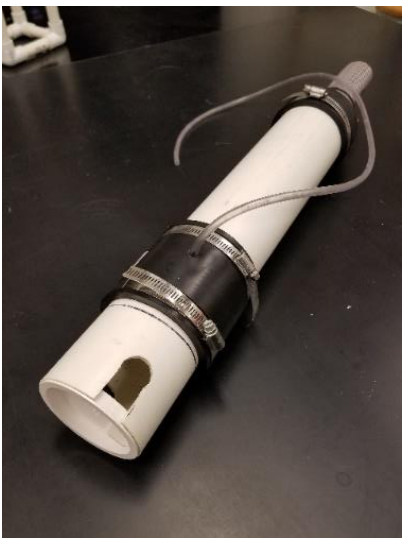
Figure 4. The constructed soil column.